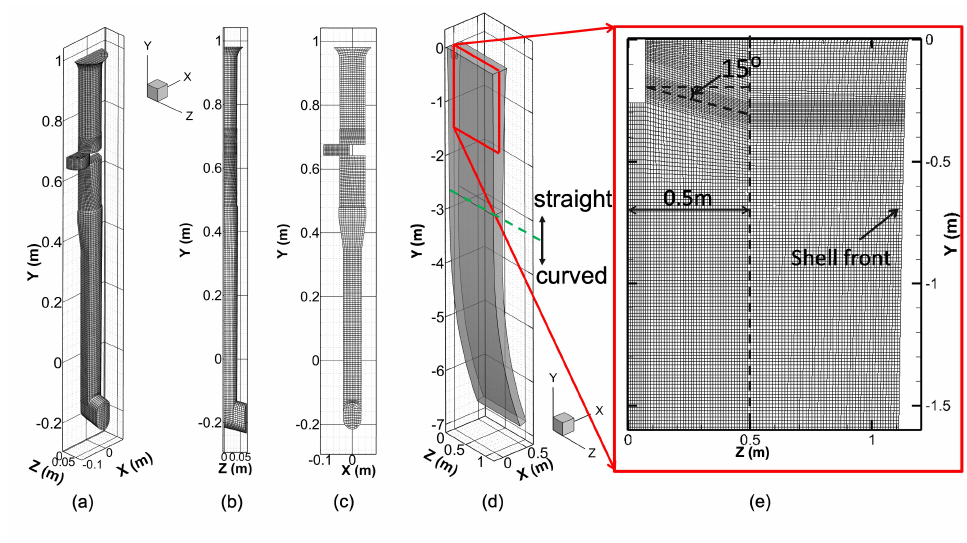
Figure 6. Flow domain and mesh: ( a ) nozzle 3D view, ( b ) front view, ( c ) nozzle center plane, side view, ( d ) liquid pool, and ( e ) liquid pool center plane.